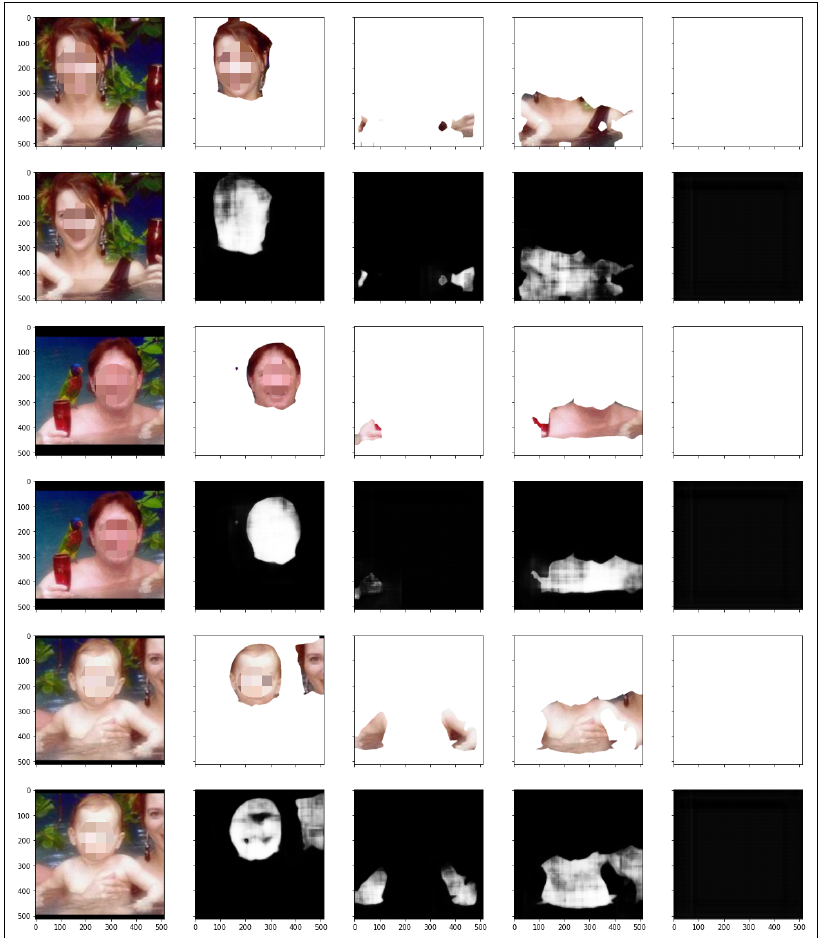
Figure 14. Processing results containing more than one person and showing each body part